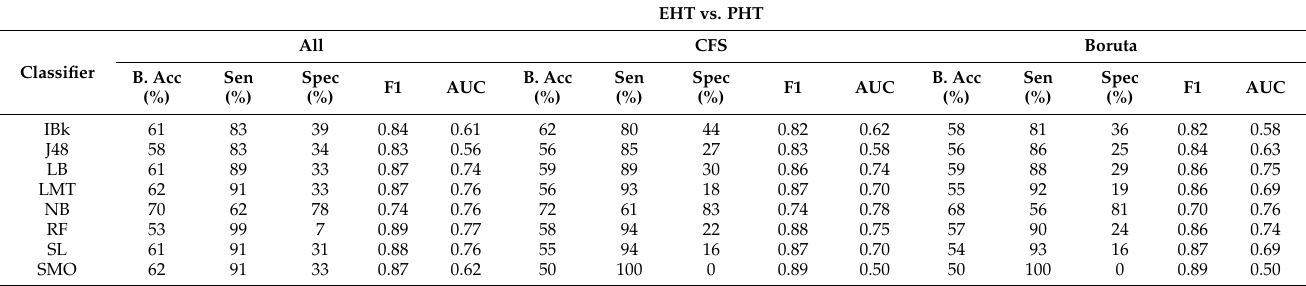
Table A3. Mean balanced accuracy, sensitivity, and specificity for EHT vs. PHT disease comparison using various classifiers with all features, CFS, and Boruta feature selection methods.